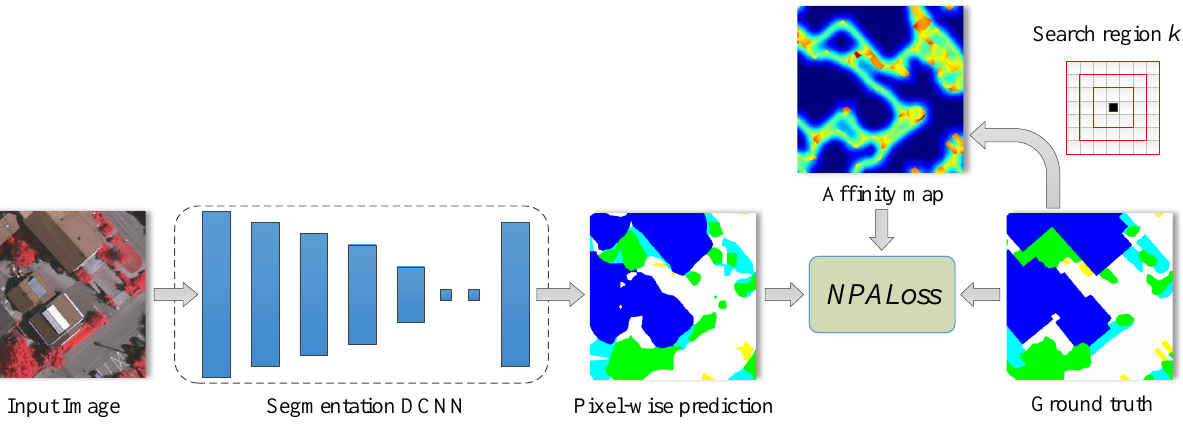
Figure 2. Overview of our framework. We replace the standard cross-entropy loss to our proposed NPALoss, which is only calculated by ground truth map and can be combined with any existing semantic segmentation networks.